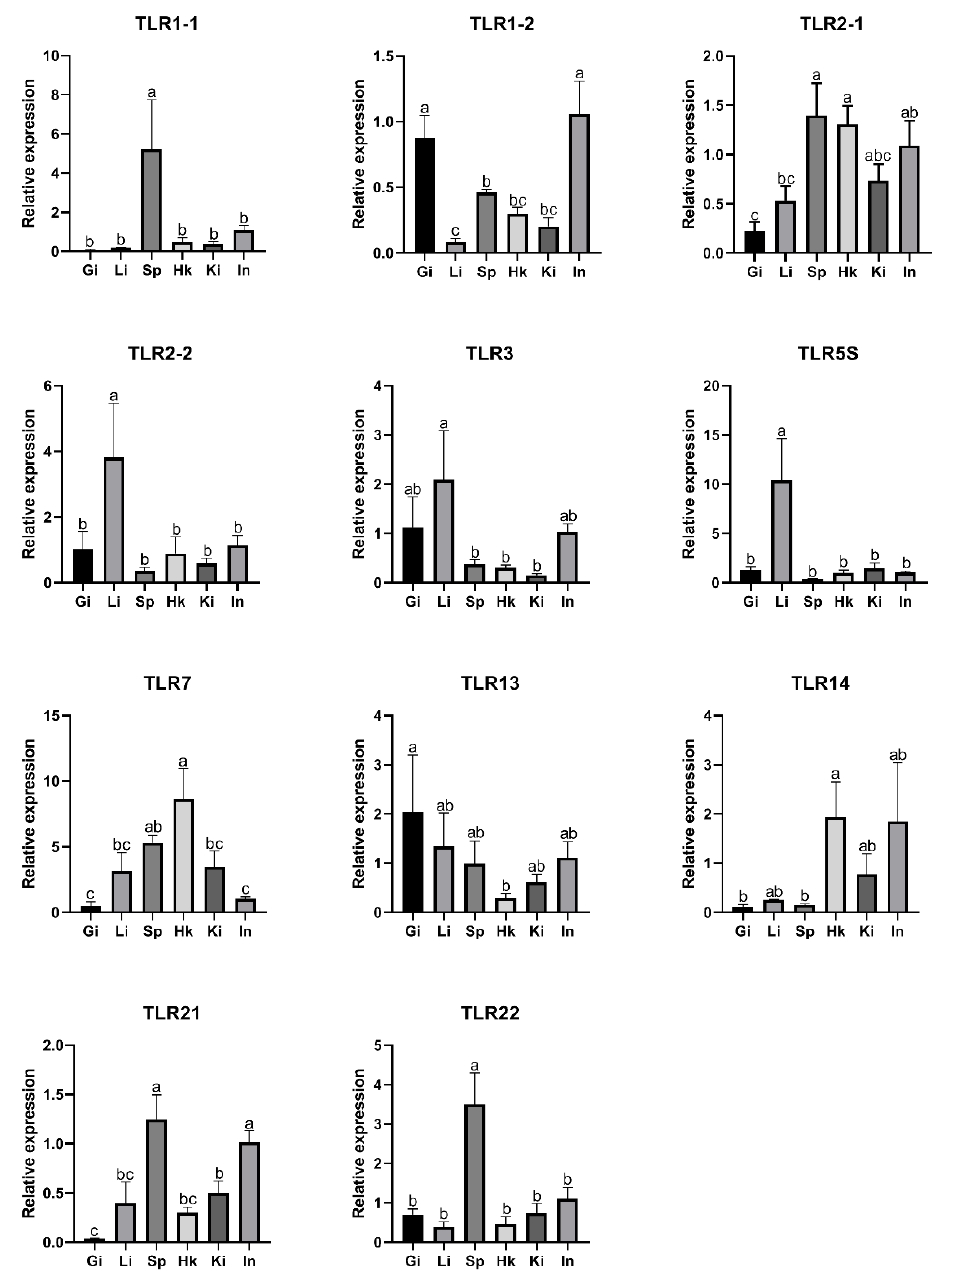
Figure 7. Expression of TLRs in selected tissues in marbled rockfish. The relative gene expression levels of SmaTLRs were normalized with β -actin. Different letters above the error bars indicated statistical significance (Duncan’s test, p < 0.05). Gi: gill; Li: liver; Sp: spleen; Hk: head kidney; Ki: kidney; In: intestine.